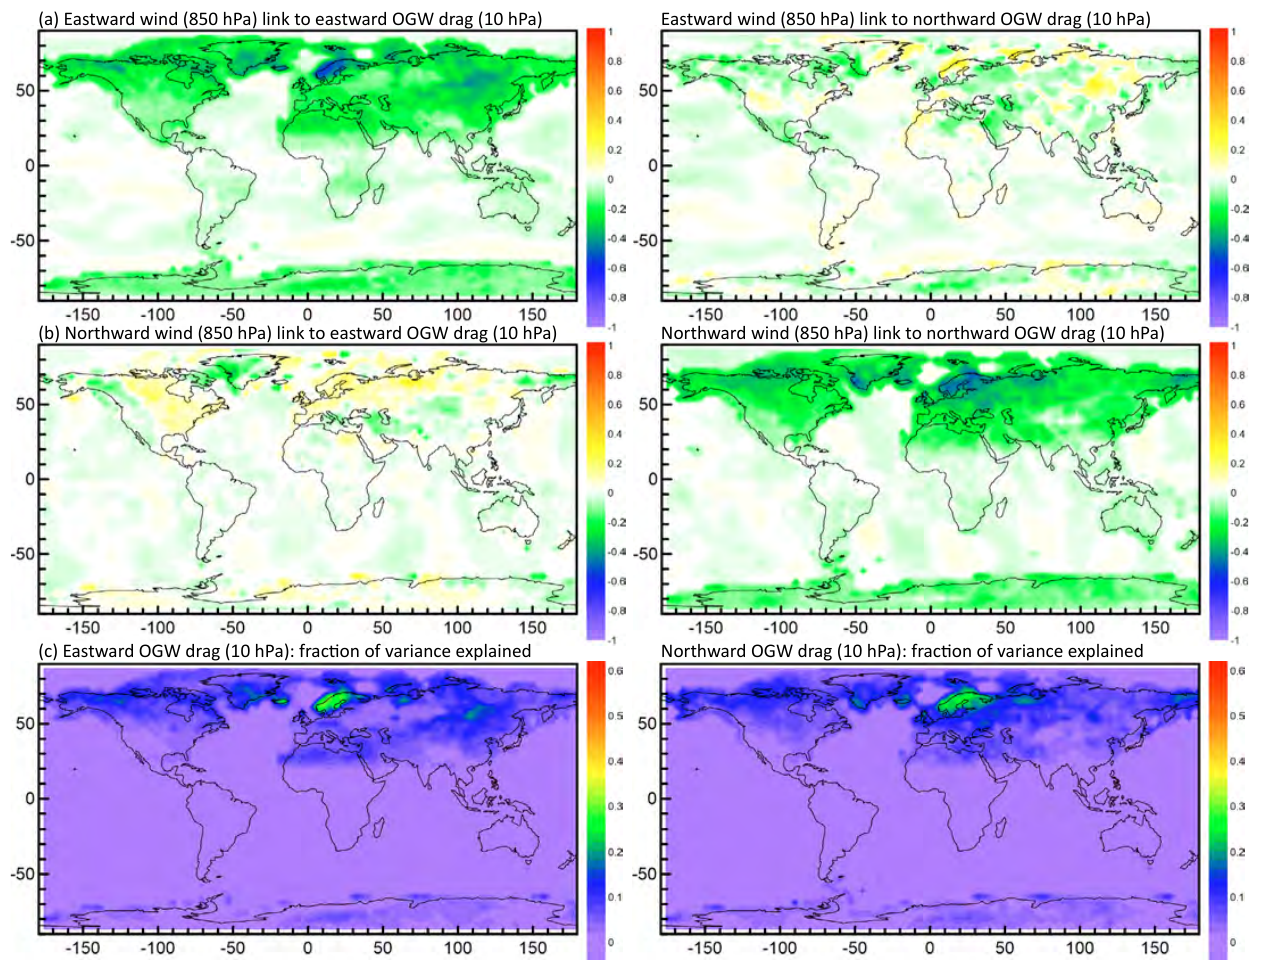
Figure 9. (a, b) Standardized regression coefficients between orographic gravity wave drag at the 10hPa level (predictand) and eastward and northward wind components at the 850hPa level (predictors), during the DJF season. (c) Coefficient of determination, i.e., the fraction of total variance of OGWD explained through the regression mappings by both components of wind at the 850hPa level. Analysis period: 1979–2010, daily data, DJF